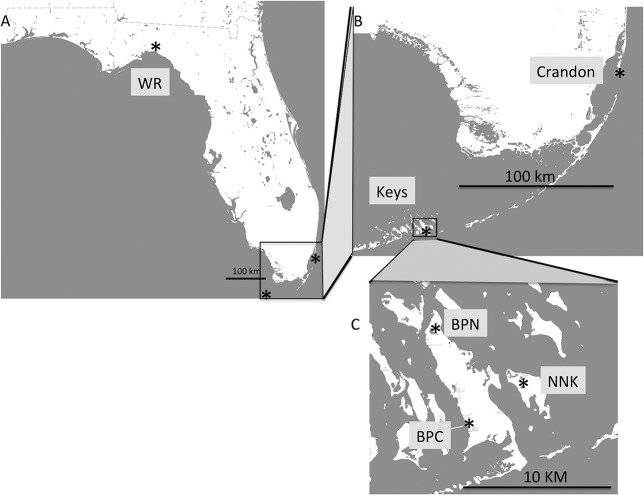

Poecilia latipinna collection sites.The study uses a nested analysis for individuals collection across Florida in two two regions, A: North Florida and South Florida. Within the southern regions were two locations, B: Crandon and the Florida Keys. Within the Florida Keys, individuals were collected at three locations, C: Big Pine Key N, Big Pine Key C and No Name Key.